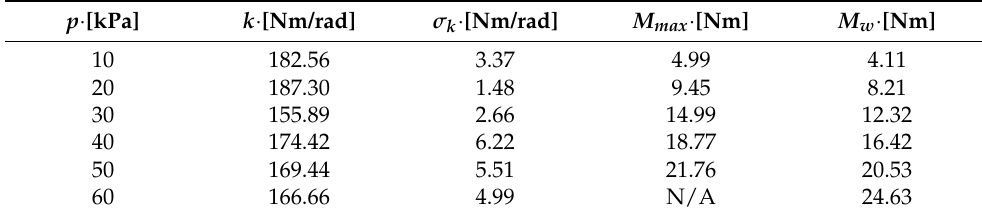
Figure 9. Experimental data and linear model on varying pressures for the considered inflatable link. Table 3. Results from the inflatable link